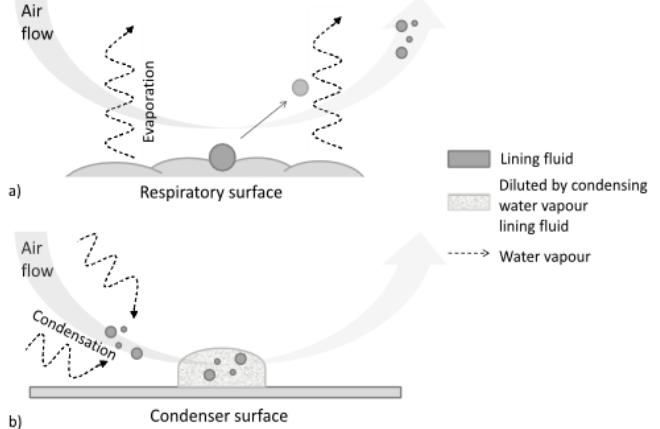
Figure 6. Formation of an exhaled breath sample. ( a ) Respiratory droplets are released from the surfaces of the airways/air spaces. Much greater quantities of water are released as vapor (dotted arrows); ( b ) when the respiratory droplets reach the condenser, they become diluted by large volumes of water vapor that are deposited as large droplets on the walls of the